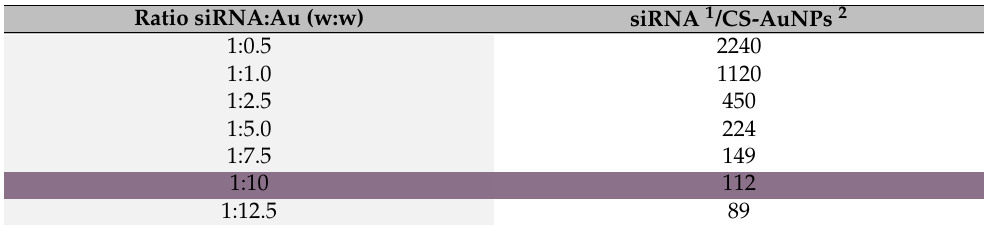
Table 1. The different weight ratio and corresponding number ratio of siRNA to CS-AuNPs. Ratio siRNA:Au